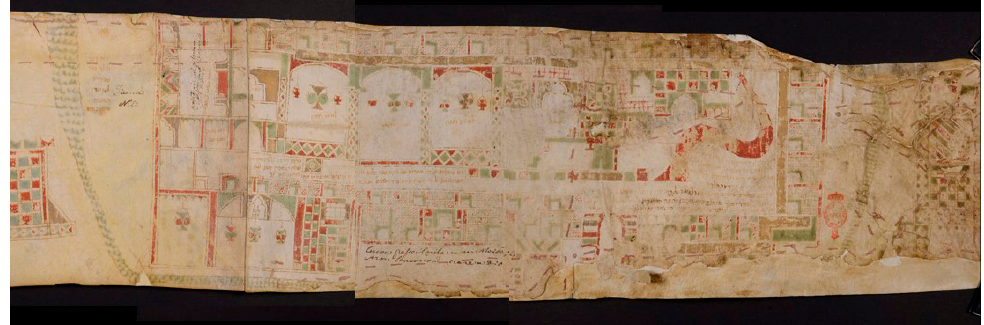
Figure 1. Florence, BNC, Ms. Magl. III, 43; Kanīsat Mūsā in Dammūh, early 14th century, by courtesy of Ministero dei beni e delle attività culturali e del turismo/Biblioteca Nazionale Centrale di Firenze.